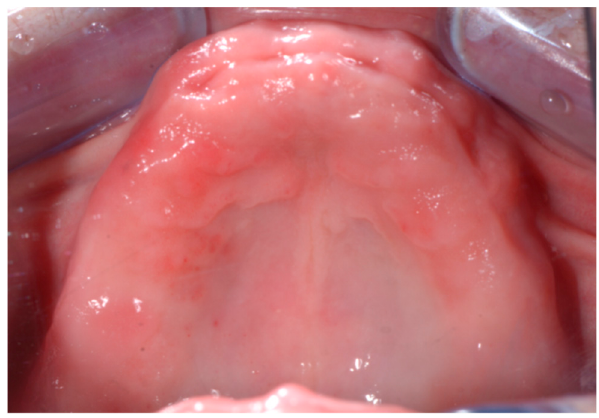
Figure 1. Edentulous maxilla.